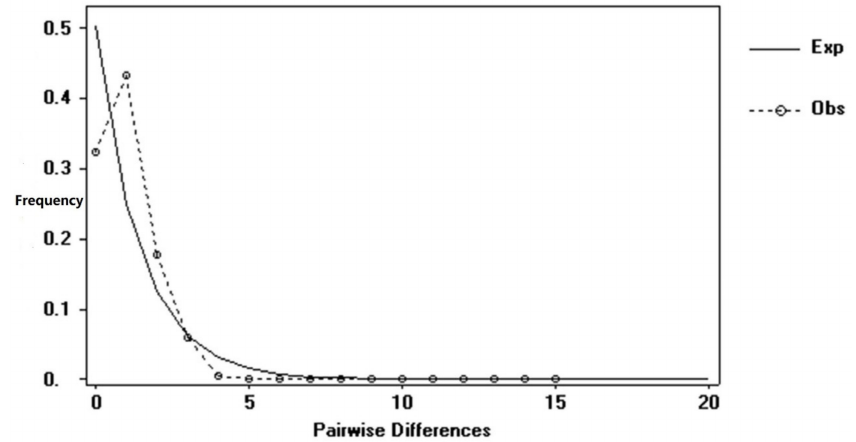
Figure3. MismatchdistributionanalysisofcpDNAhaplotypesfor L.formosana populations. Thevertical axis represents frequency, whereas the horizontal axis shows the number of pairwise di ff erences. Note: The line represents the distributions expected for a population, and the dotted line represents the observed